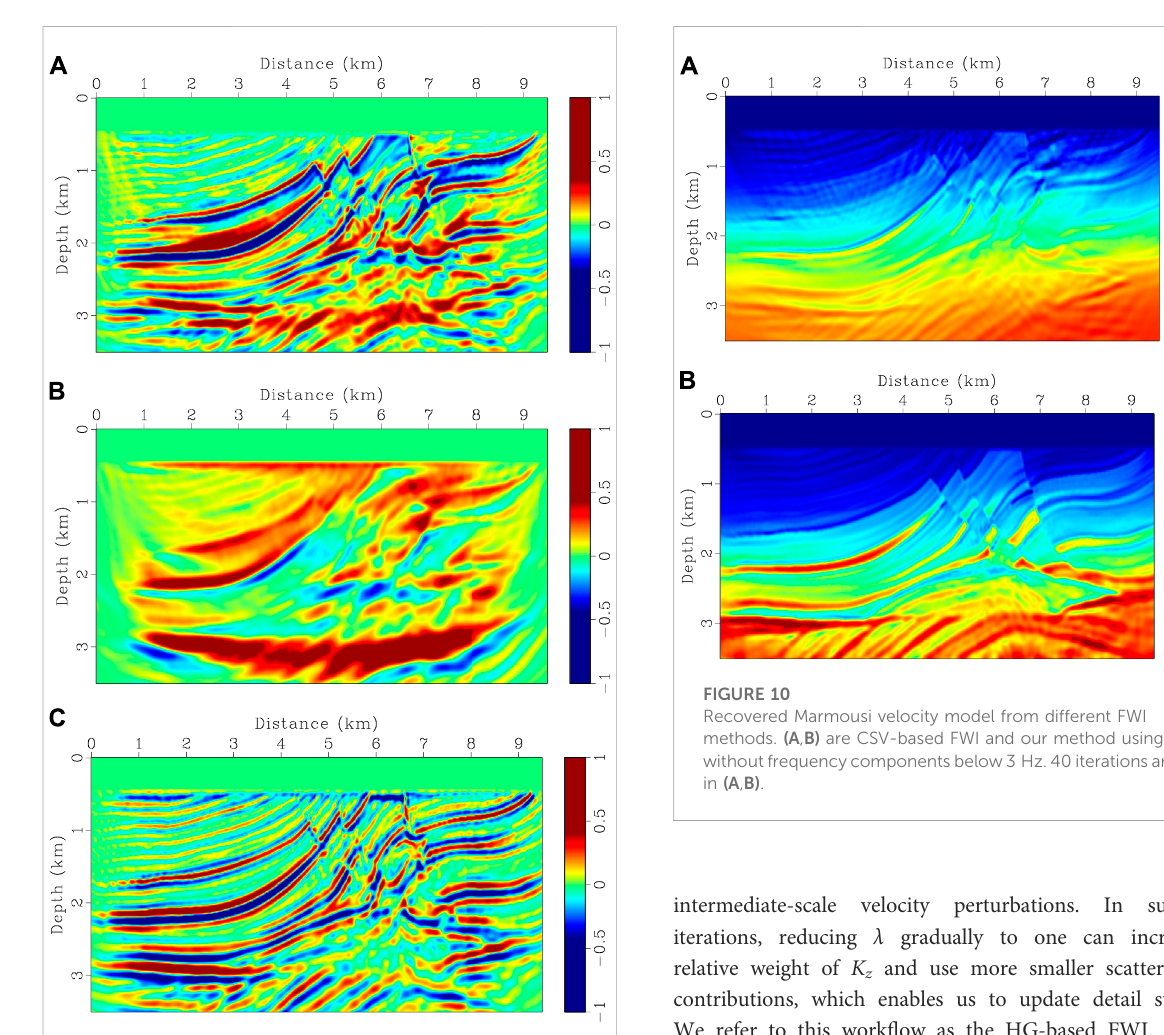
FIGURE 9 Comparisons of different gradients in the fi rst iteration for Marmousi model. (A) CSV-based gradient, (B) velocity and (C) impedance gradients. The magnitude of each panel is normalized with respect to their maximum values.